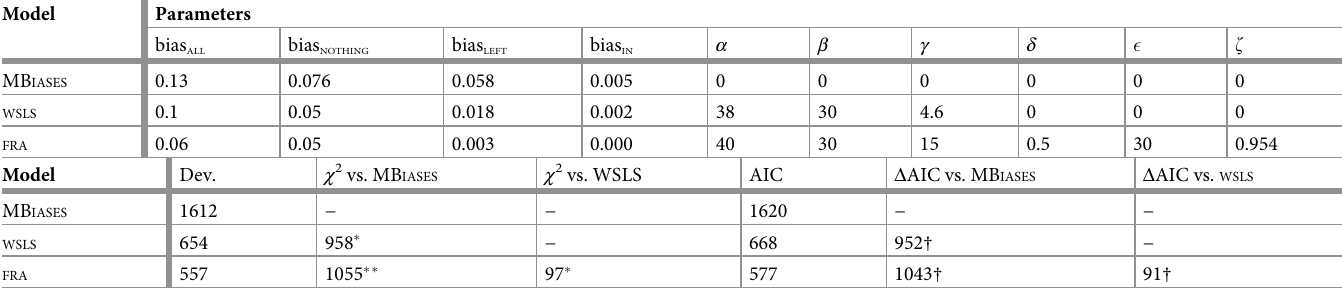
that FRA provides a better account of the underlying choice process and that this model’s better fit to the data is not due to over-fitting. Moreover, the AIC shows that there is strong support in favor of FRA with respect to both WSLS and MB IASES , even if we take into account this model’s greater complexity, as introduced by the extra parameters. We simulated 45 dyads playing 60 rounds of the game, for the three models with the fitted parameters from Table 3. In Fig 9 we can see the behavior of these models. In the left panel we can see that FRA and WSLS come quite close to the observed behavior at the dyadic level, and that the former predicts a better coordination than the latter. In the right panel we can see the kernel density estimate of DL INDEX for observed and simulated data. For humans, values of